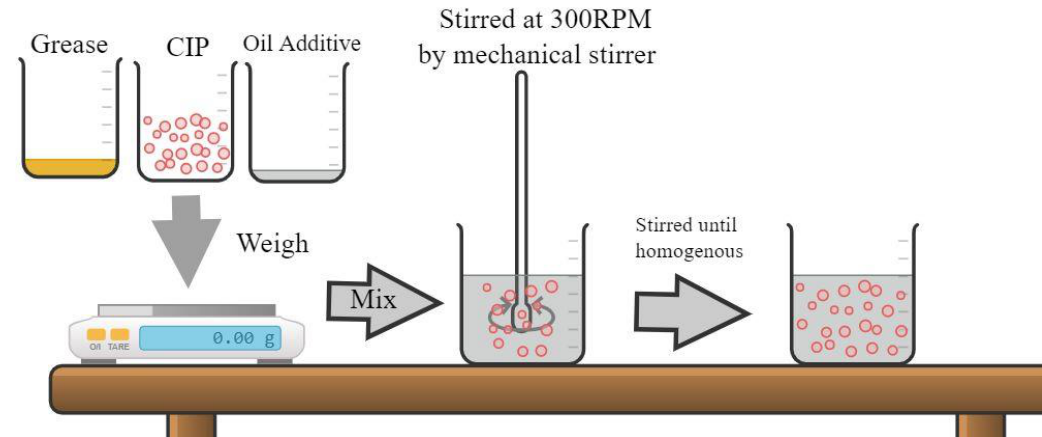
Figure 1. The schematic of the fabrication process of MRG samples. Table 1. The composition of the sample of MRG with a different types of oil dilution.